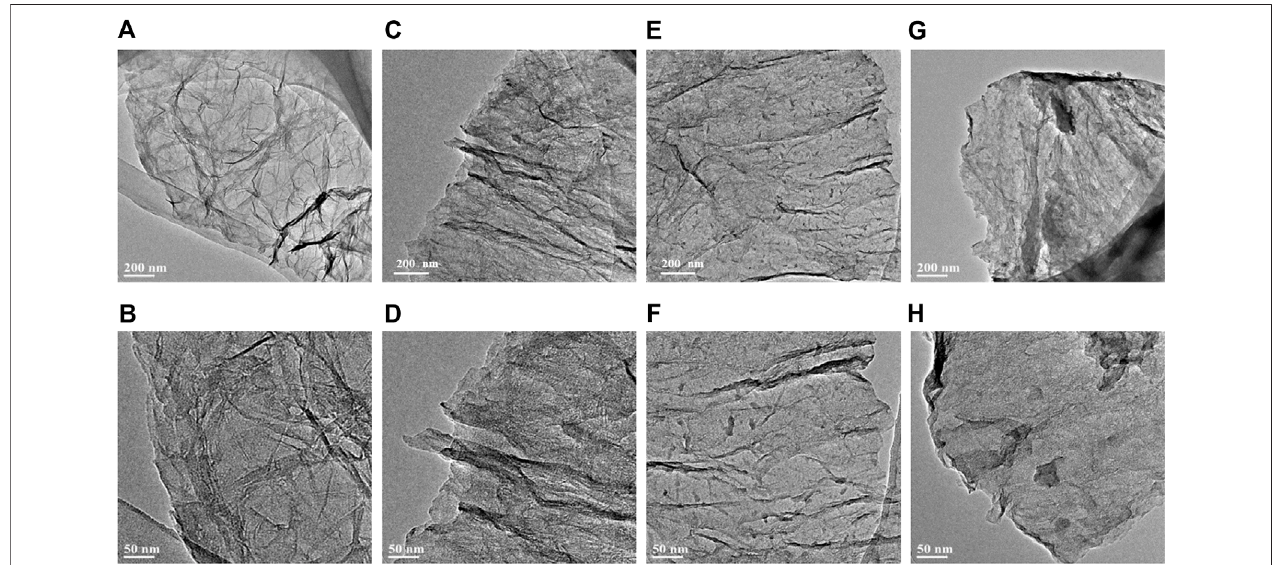
FIGURE 1 | TEM images of G (A,B) , NG-0.5 (C,D) , NG-1 (E,F) and NG-2 (G,H) .